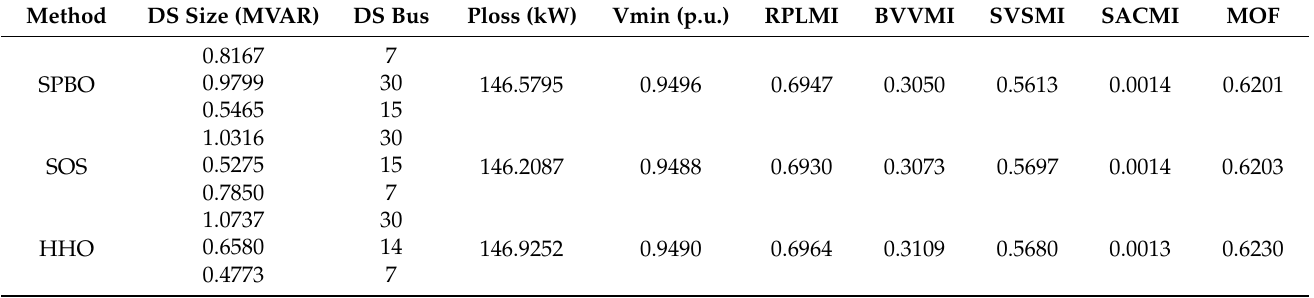
Table 3. Comparison of results for exclusive D-STATCOM allocation (case-2) for 33-bus test system.